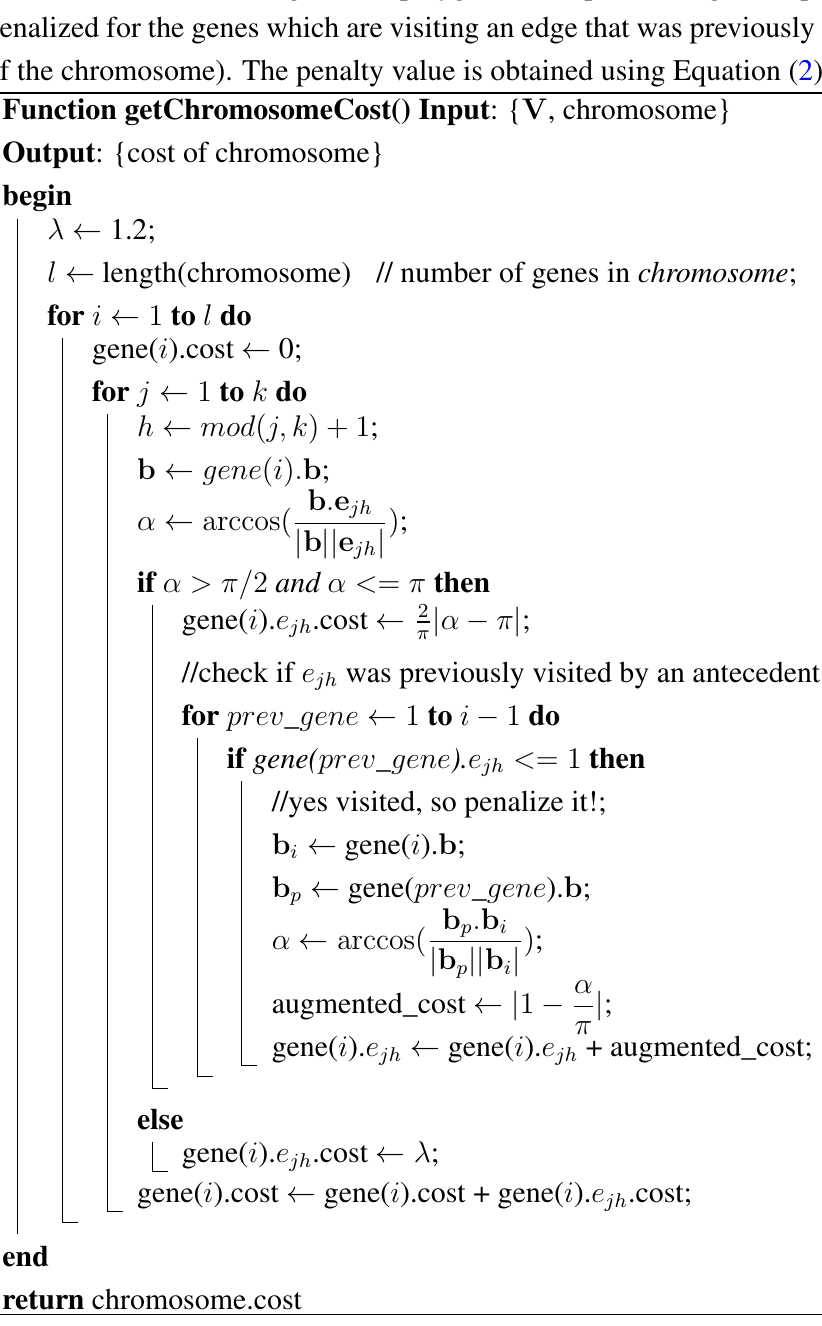
ALGORITHM 4 : Algorithm to compute the cost of a chromosome and its genes. The inputs are V , the vertices’s matrix and chromosome . The cost value among each individual gene in the chromosome and each edge of the polygon is computed using the Equation (1). The cost value gets penalized for the genes which are visiting an edge that was previously visited by an antecedent gene of the chromosome). The penalty value is obtained using Equation